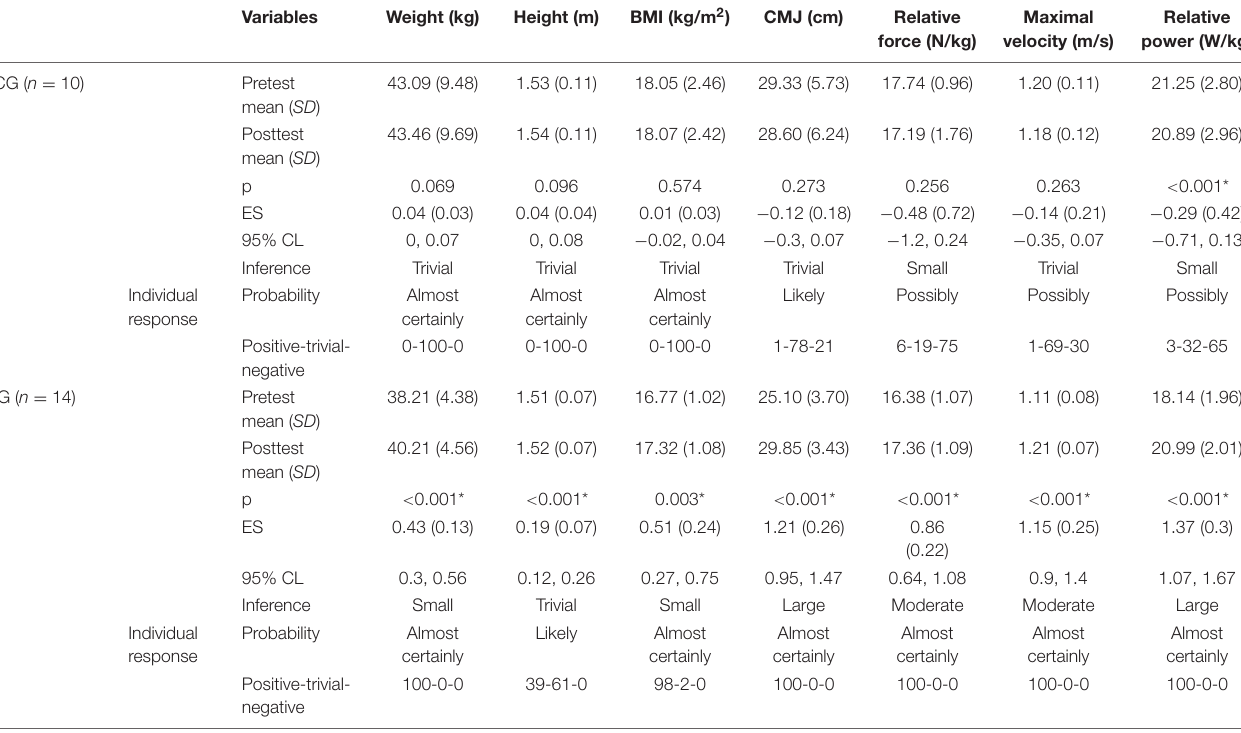
TABLE 3 | Intragroup comparison of anthropometric and jumping performance variables pre-post